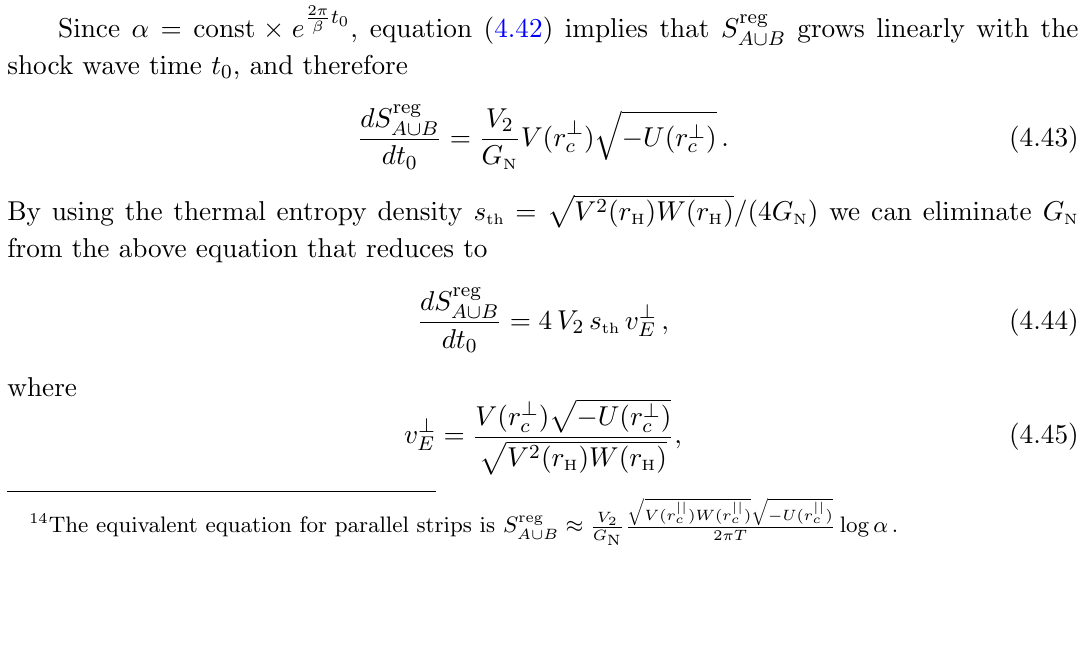
Figure 9 . Regularized entanglement entropy of orthogonal strips S reg a function of log (cid:11) . The curves correspond (from bottom to top) to =T 2 = 12 : 3 (blue curves) and B coe(cid:14)cient given by the equation (4.42). We are considering strips of very large width, such